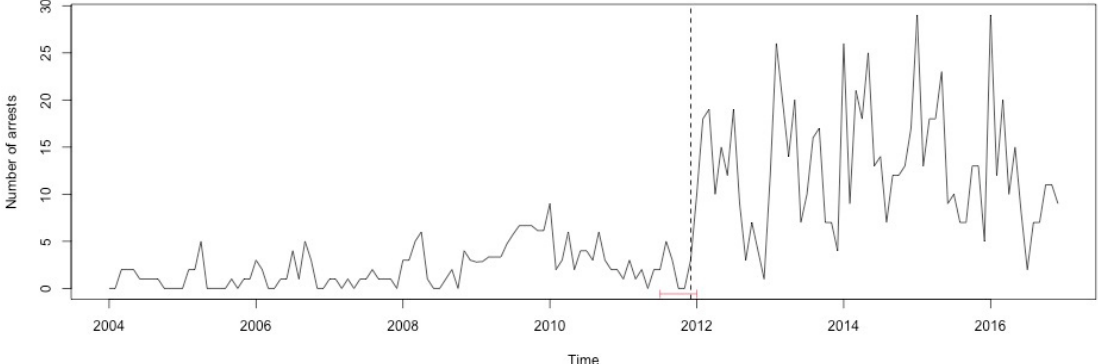
Figure A31. Precursor arrests 2004–2016 in the Czech Republic and structural breaks.